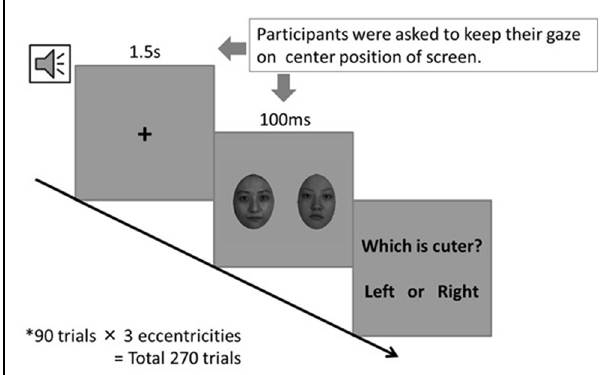
FIGURE 2 | The procedure of cuteness judgment. We asked participants “which is more beautiful?” in case of beauty